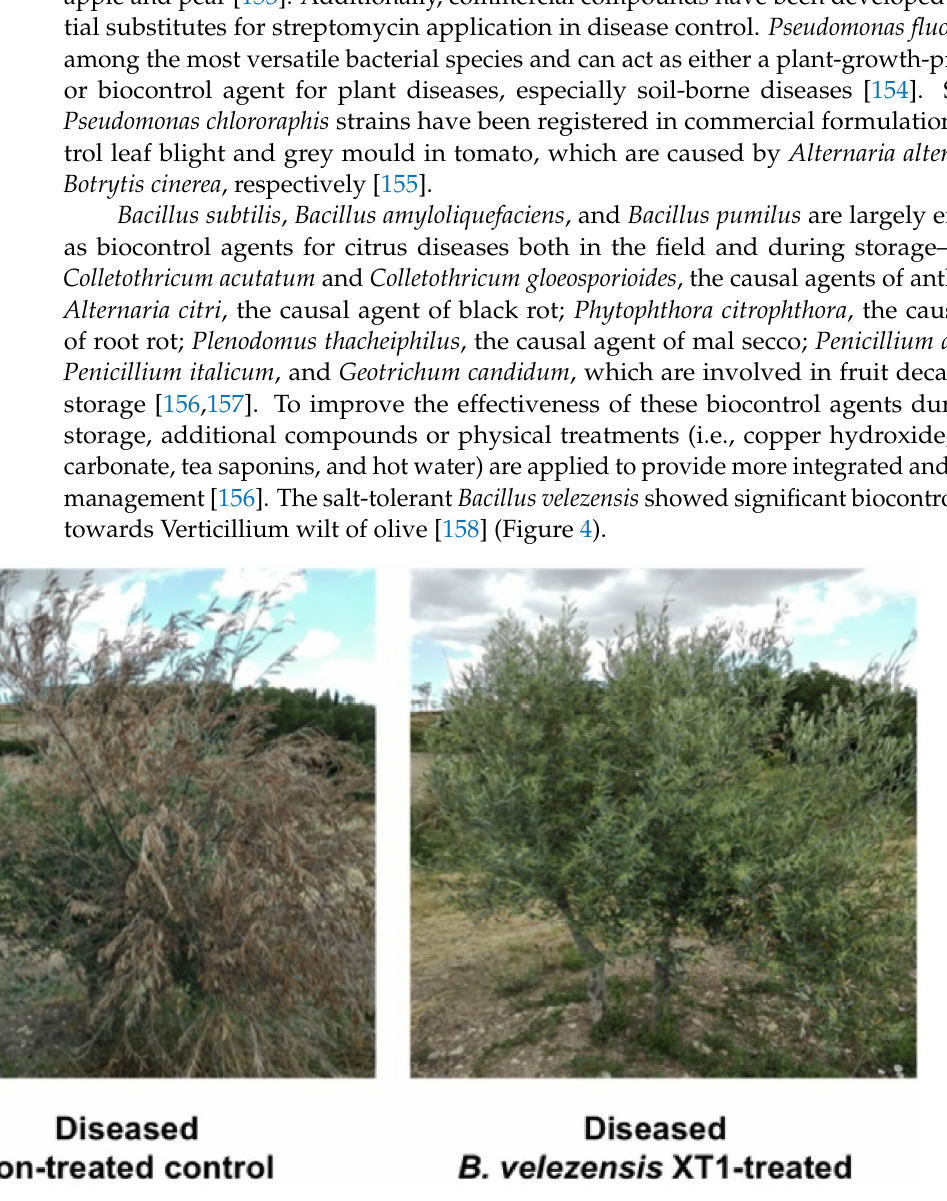
Figure 4. Olive Verticillium wilt, caused by Verticillim dahliae , treated with Bacillus velezensis : olive trees in the field experiment before and after the treatment with B. velezensis strain XT1. (Reproduced from